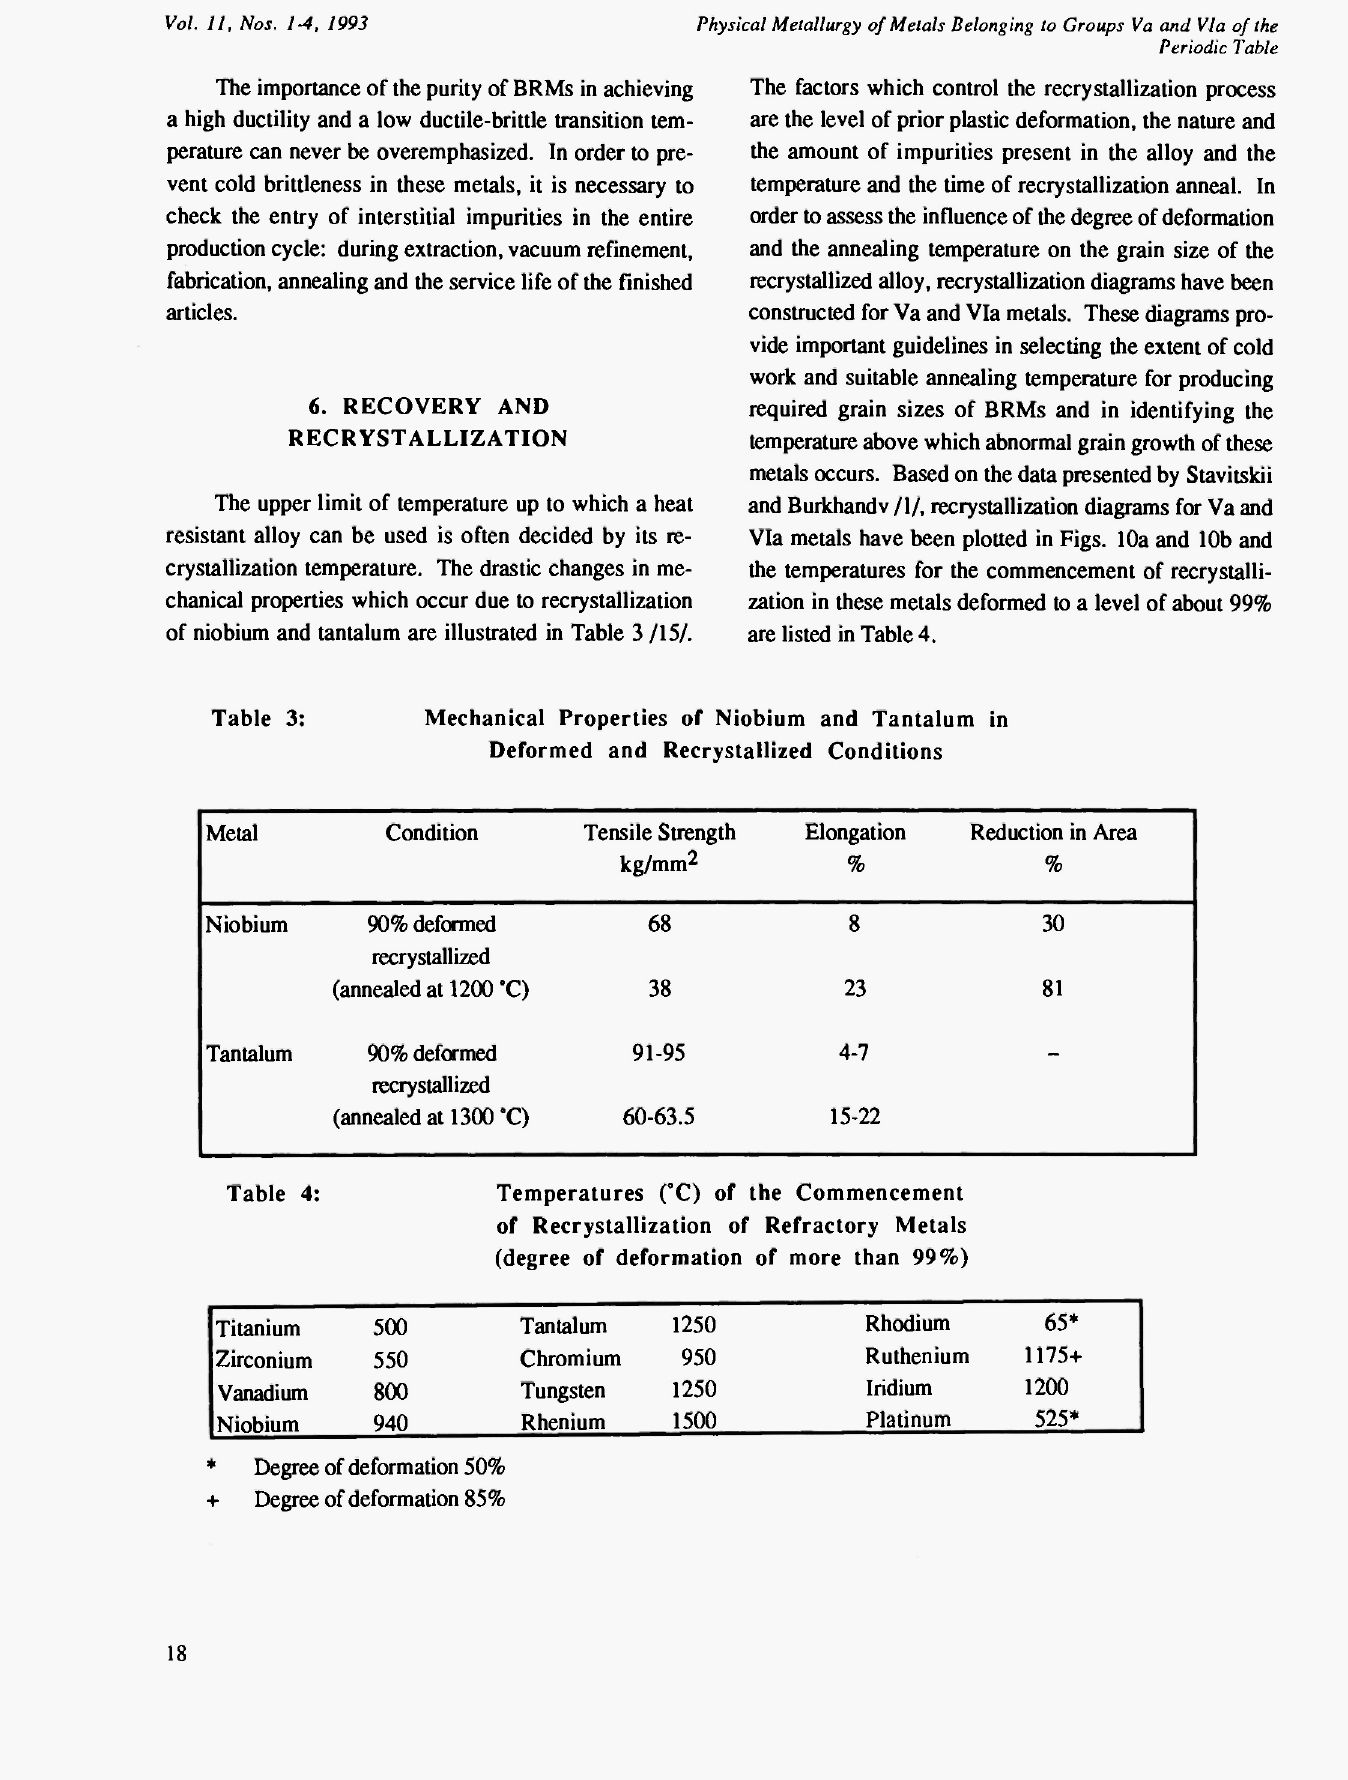
Mechanical Properties οΓ Niobium and Tantalum in